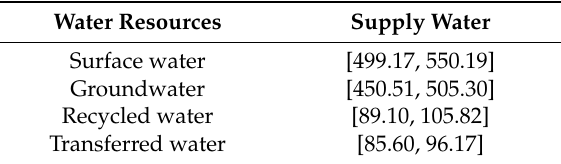
Table 2. The amount of water supply (10 6 m 3